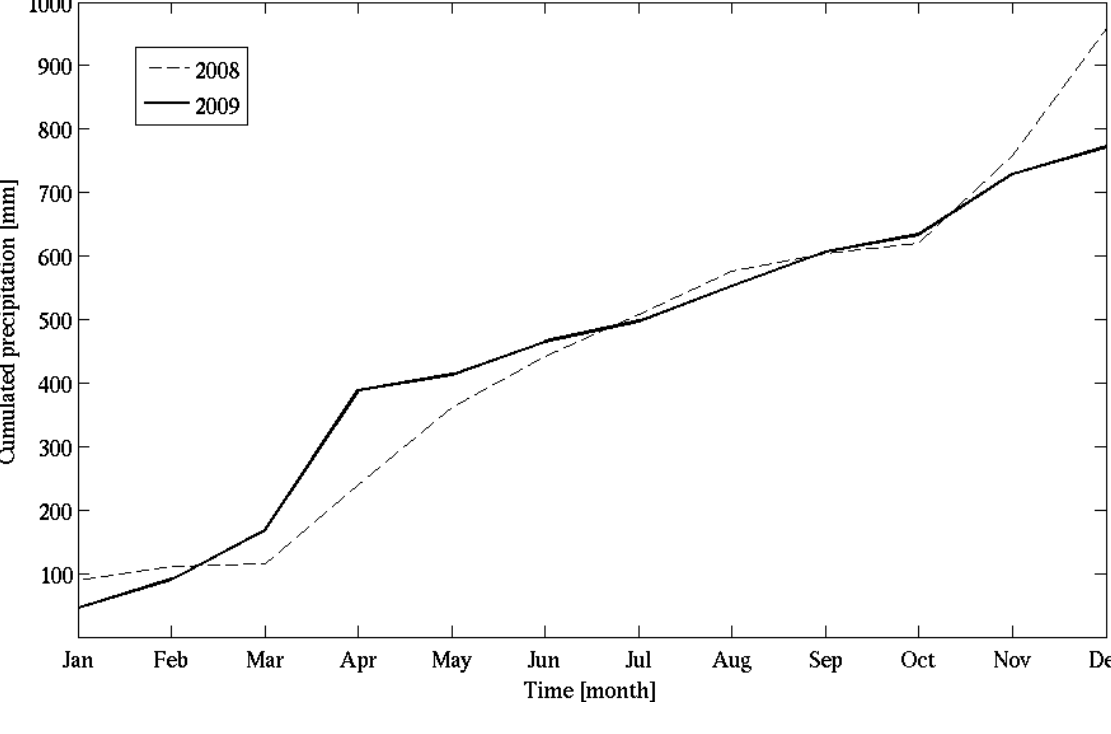
Figure 5. Volumetric soil water content (in m 3 m - 3 , left scale) measured near Barbera vine rows at Cocconato 10 cm below the soil surface, and daily cumulated precipitation (in mm, right scale) measured at Cocconato during the 2009 vegetative season. For the sake of reference, the wilting point for the silty clay loam soil is 0.22 (m 3 m - 3 ), while the porosity is 0.47 (m 3 m - 3 )